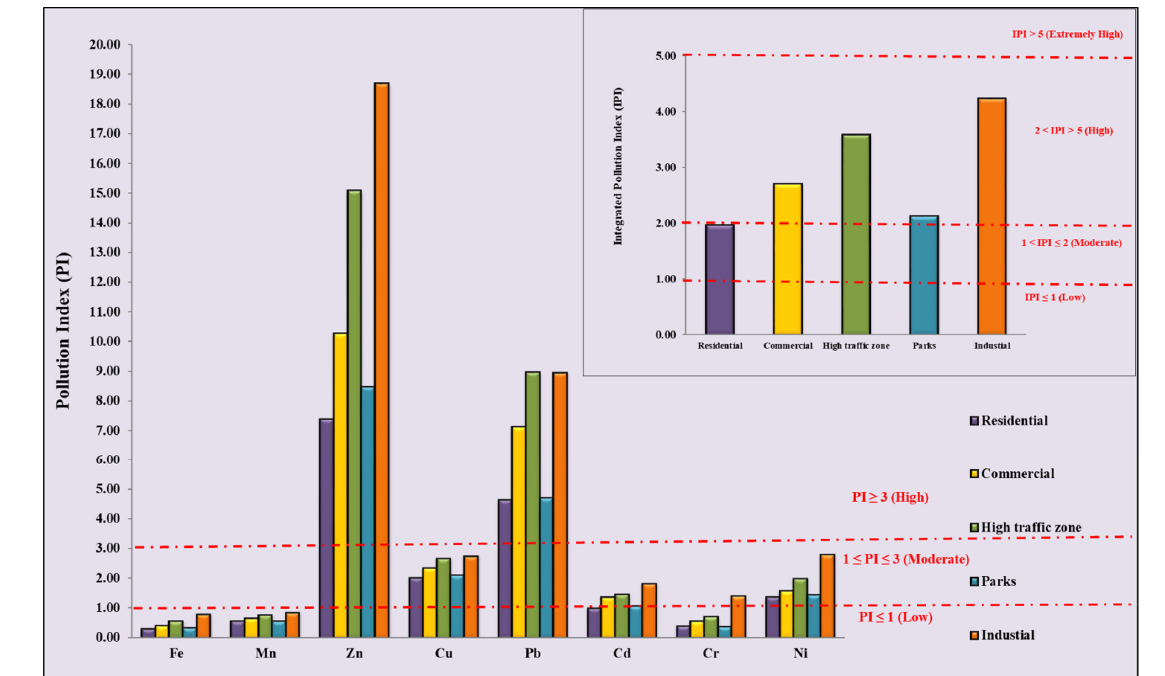
Figure 2. Pollution indexes (PIs) and integrated pollution indexes (IPI) of HMs in the dust of Lucknow over different functional areas.